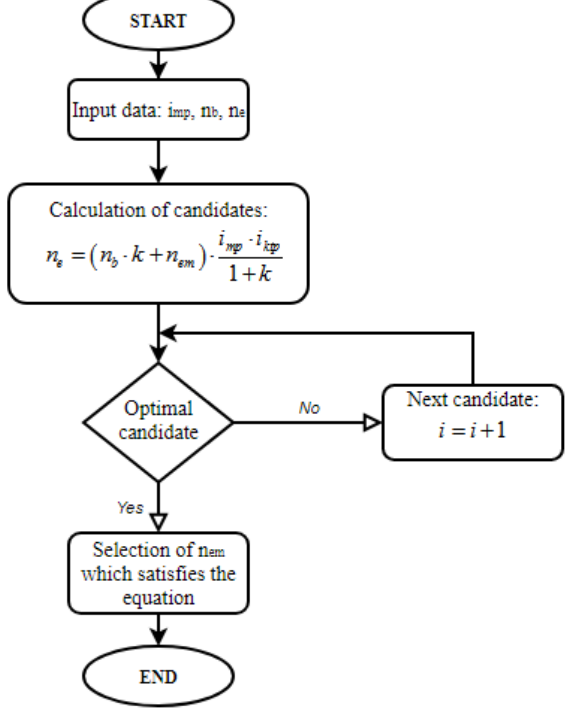
Figure 5. HM operating mode algorithm RB : During braking, the regenerative braking mode is activated, which uses the kinetic energy of the vehicle and recharges the battery.